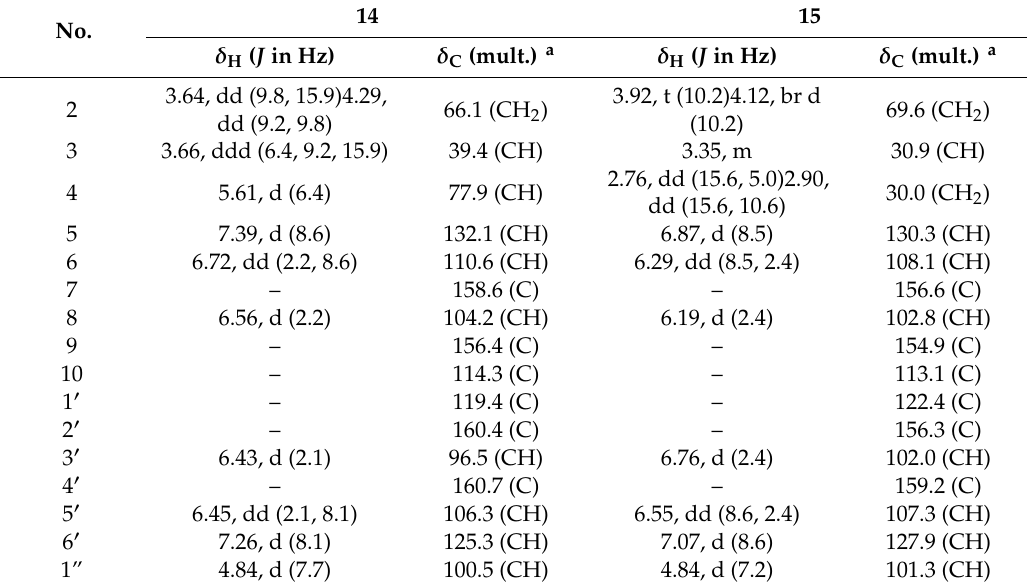
Table 3. 1 H (400 MHz) and 13 C (100 MHz) NMR data for compounds 14 and 15 in DMSO- d 6 .